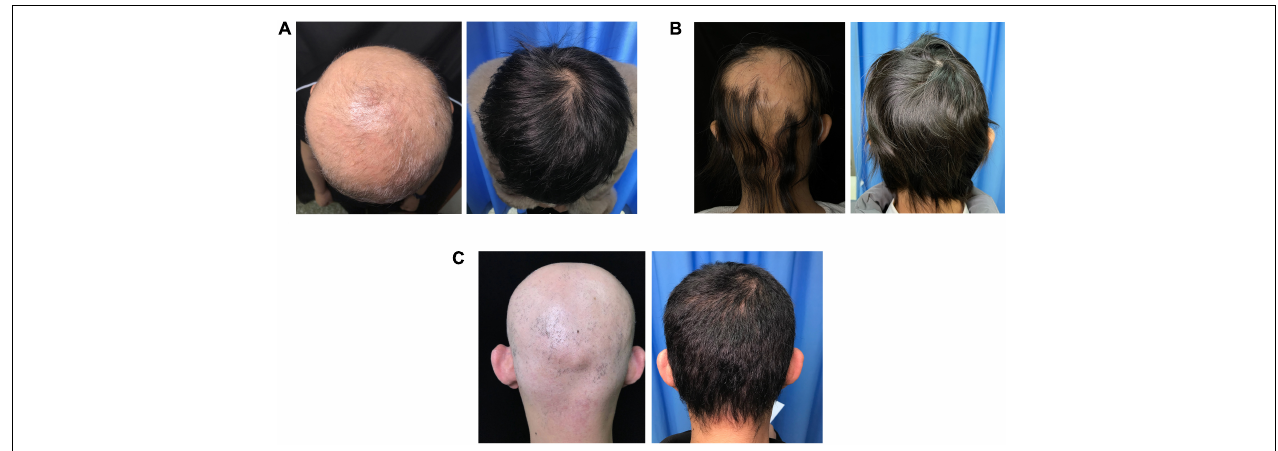
FIGURE 2 | Photographs of three representative patients in the three groups. (A) Patient in the SCs group with the SALT score of 100% prior to treatment and 0% after 18 months of treatment. (B) Patient in the tofacitinib group with the SALT score of 75% prior to treatment and 0% after 7 months of treatment. (C) Patient in the combined group with the SALT score of 100% prior to treatment and 0% after 31 months of treatment.